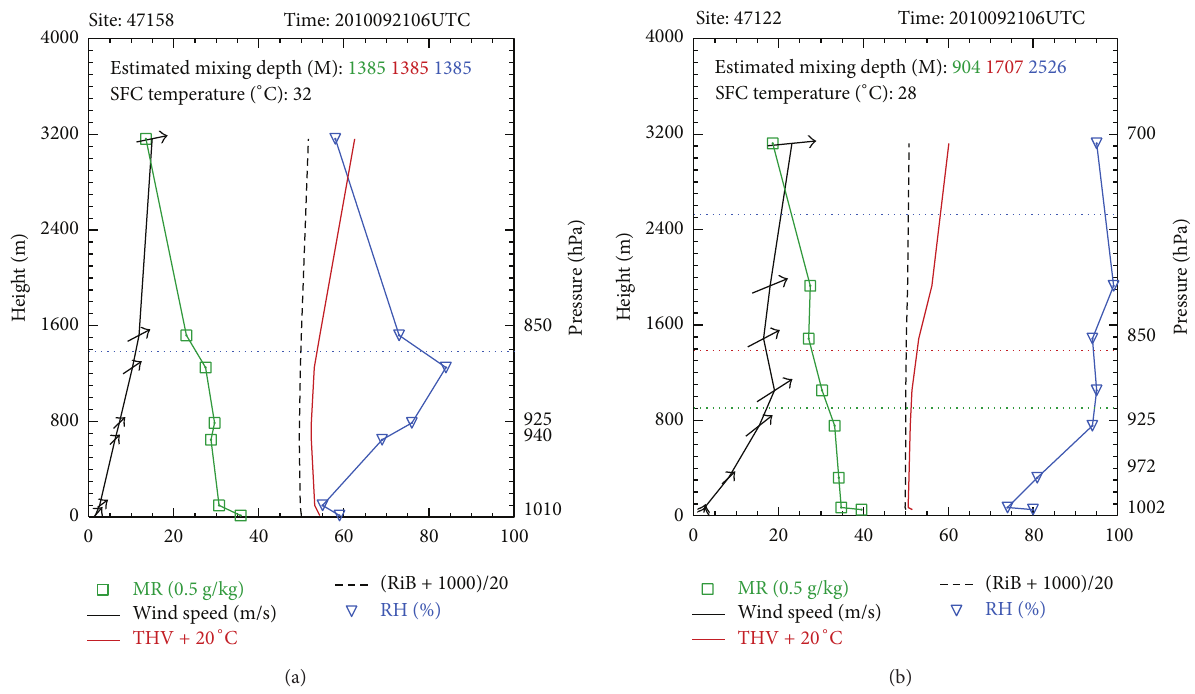
Figure 14: Vertical profiles of water vapor mixing ratio (MR), virtual potential temperature (THV), relative humidity (RH), horizontal wind speed, and the bulk Richardson number (RiB) measured at Gwangju (a) and Osan (b) radiosonde sites. The arrows denote horizontal winds at each level, and the horizontal dotted lines denote maximum gradient levels for each